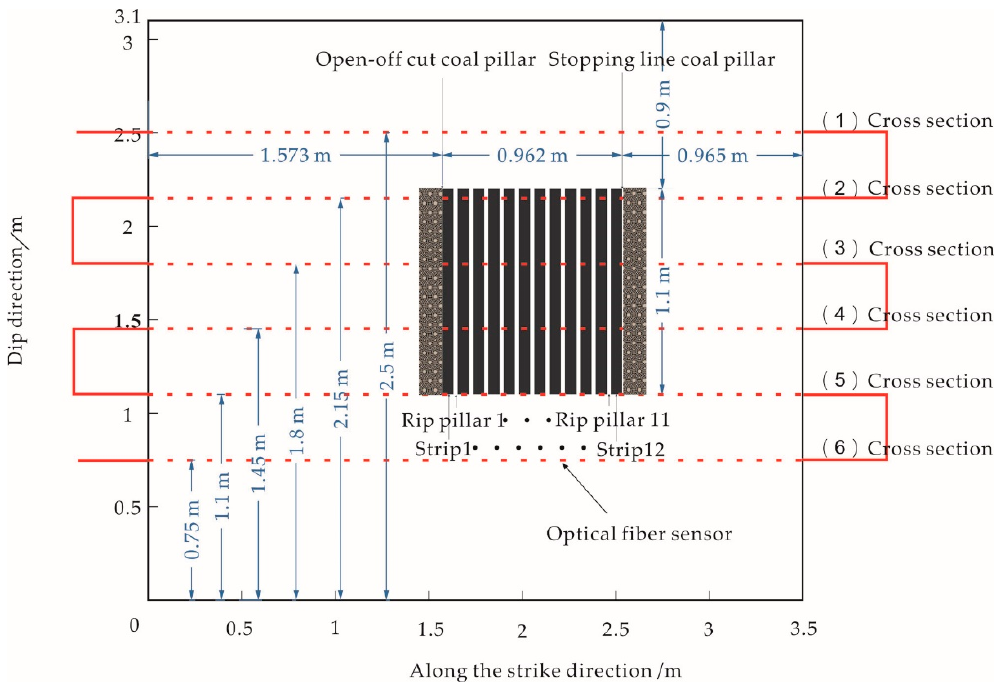
Figure 3. Model box size and layout optical fiber sensor.